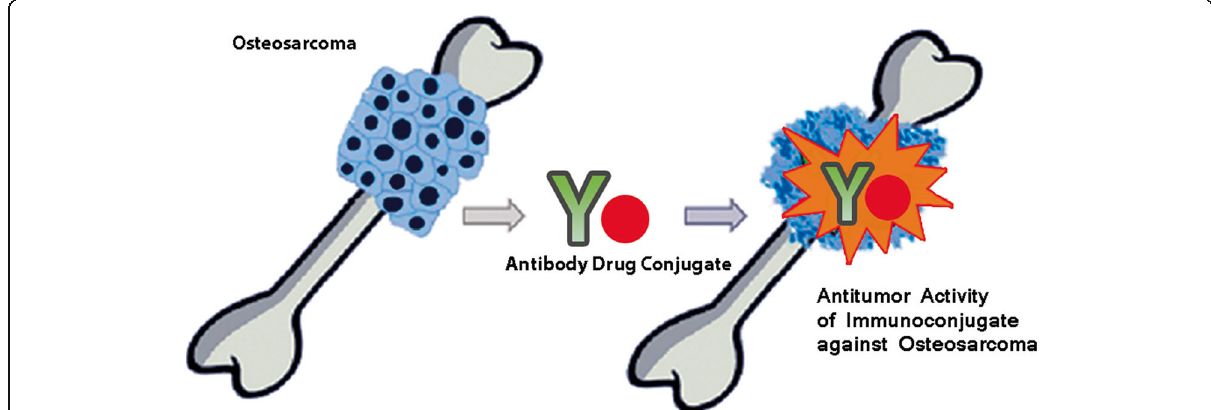
Fig. 3 OS targeting by antibody-drug conjugates wherein the cytotoxic agents and other therapeutics are linked to antibody designed against specific cell target (OS)